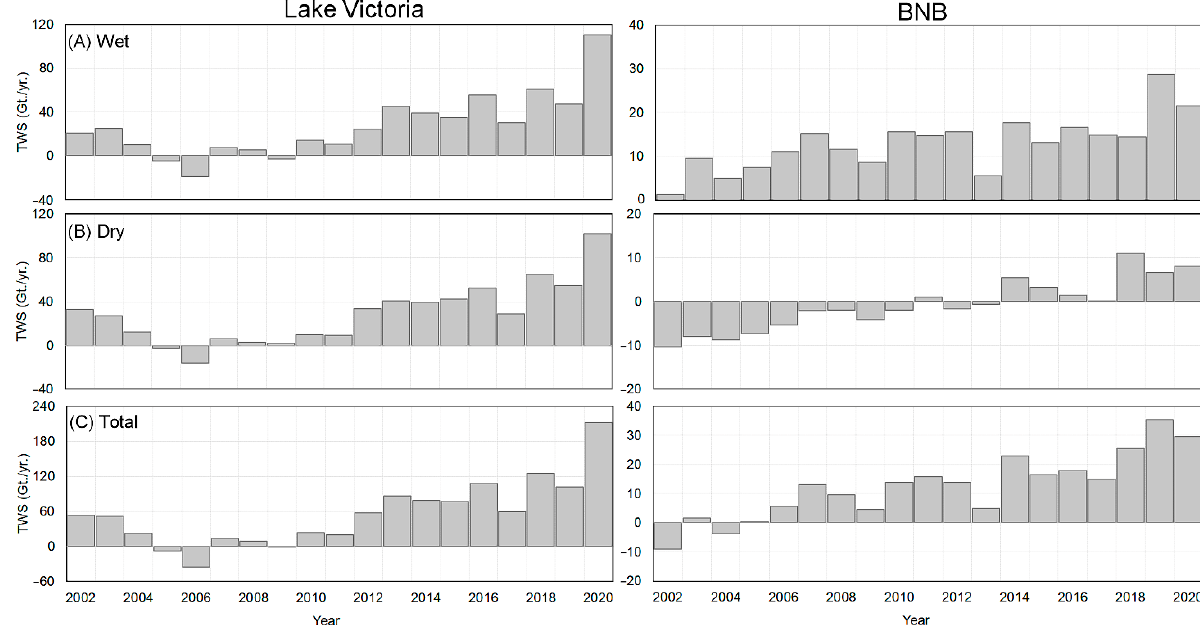
Figure 5 . TWSA dynamics during the wet and dry seasons between 2002 to 2020 across the two main water towers in the NRB, Lake Victoria, and BNB water towers.